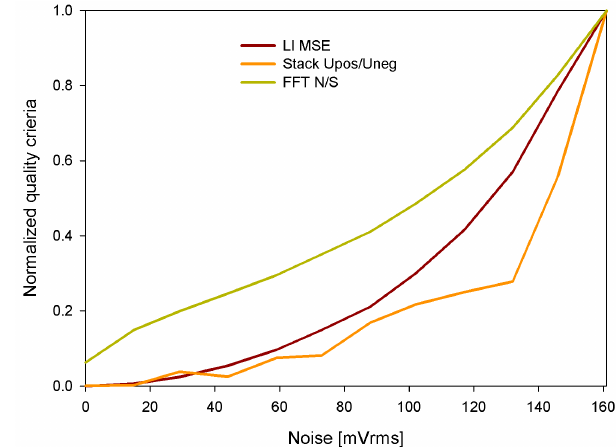
Figure 12. Quality criteria over noise level of test data set without